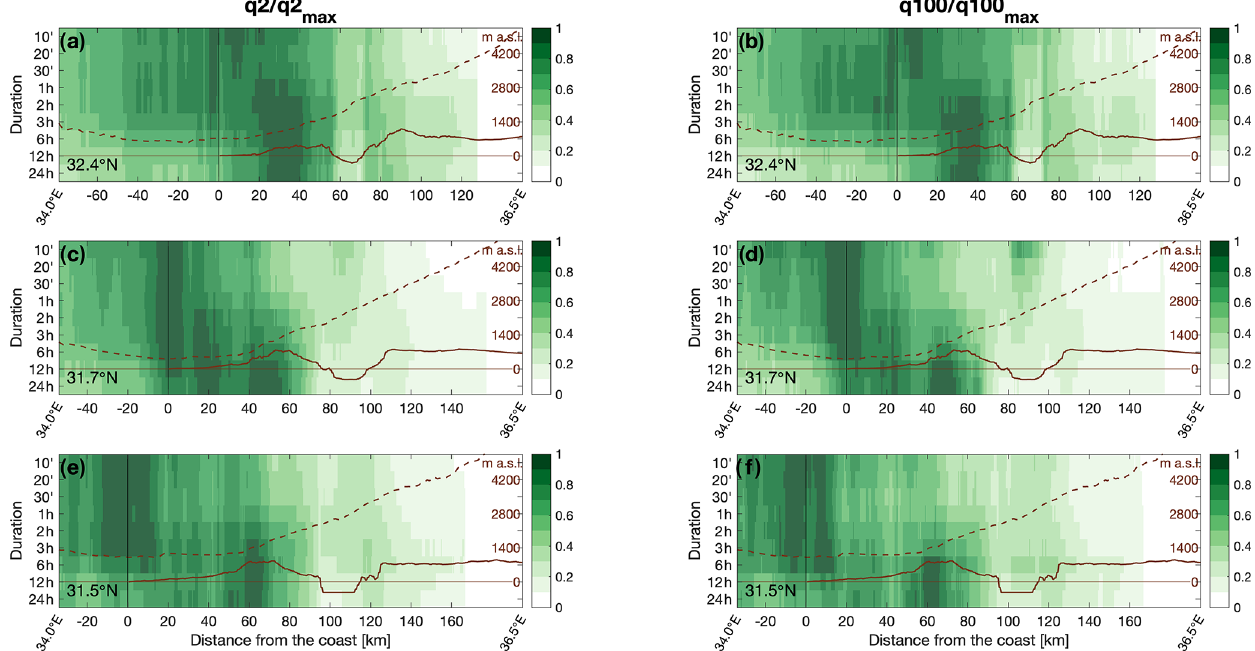
Figure 7. Longitudinal variations in the 2- (a, c, e) and 100-year (b, d, f) return levels along the three transects (see Fig. 1) as a function of the distance from the coastline ( x axis) and of duration ( y axis). Transects are obtained by averaging the 10km region surrounding the three latitudes. The orographic profile and the sampling height of the lowest non-blocked radar beam are superimposed as solid and dashed lines, respectively (see right-hand side y axis). In order to have comparable values, the return levels at each duration are normalized over the maximum value along